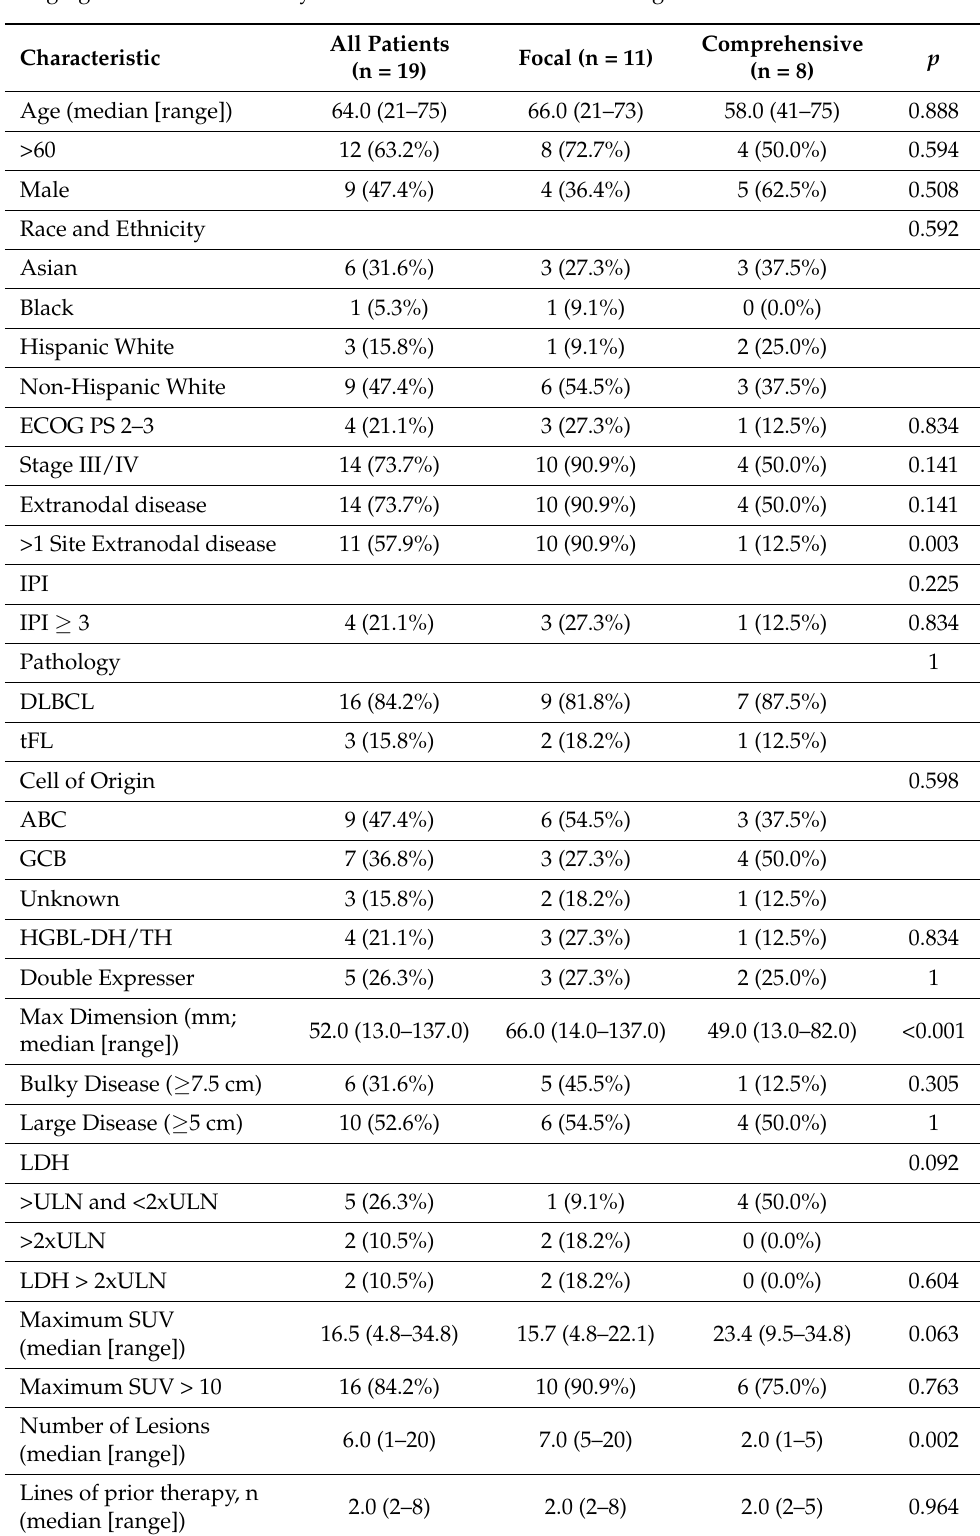
Table 4. Patient and treatment characteristics of patients who underwent CAR T-cell therapy and bridging radiation stratified by extent of radiation volume